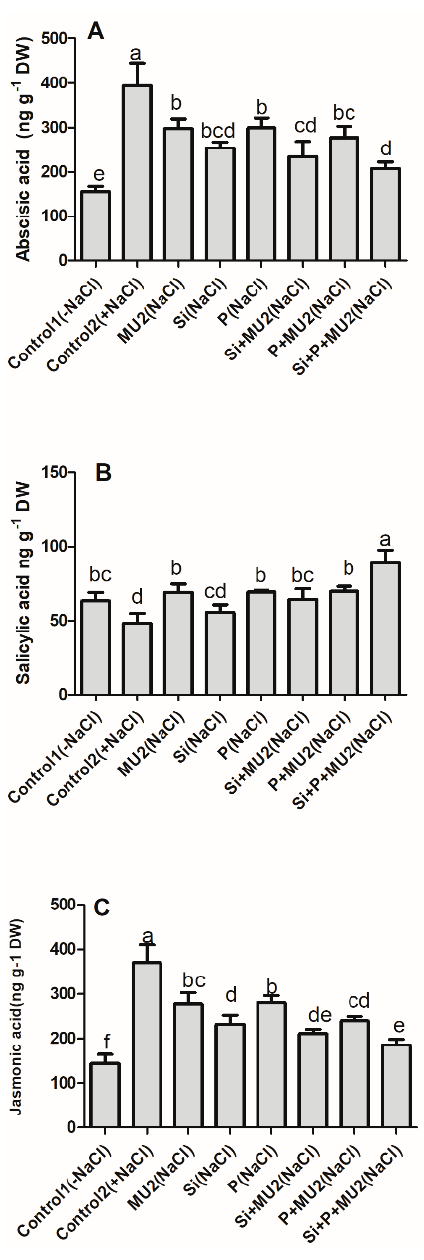
Figure 5. P. koreensis MU2 regulates the endogenous phytohormones in soybean plants. Concentration of different phytohormones: ( A ) Abscisic acid; ( B ) Salicylic acid; ( C ) Jamonic acid. Error bars represent standard deviations. Each data point represents the mean of at least three replications. Bars with different letters are significantly different from each other at p ≤ 0.05.